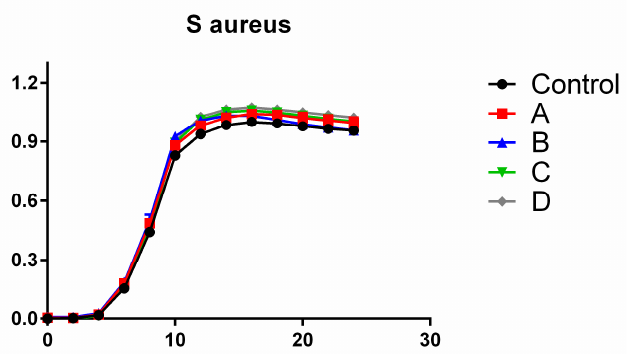
Figure 17. Growth curves of the silver-free polymers at 1 mg/mL against S. aureus (Control).